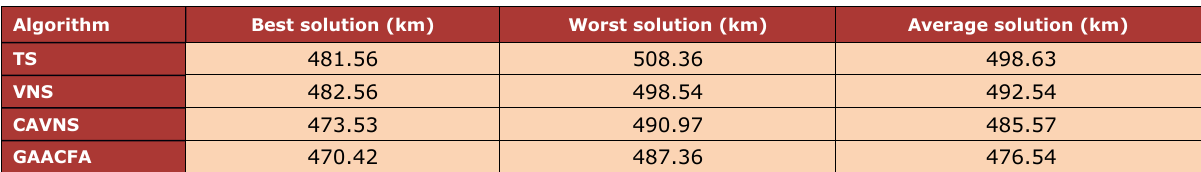
Table 2. GAACFA and the other algorithms in solving path length in P02